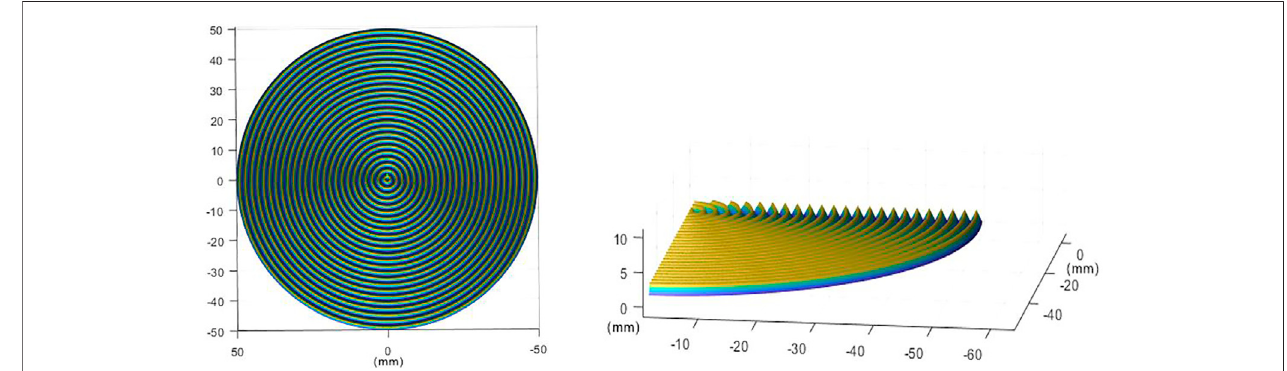
FIGURE 3 | V-slot model drawing.